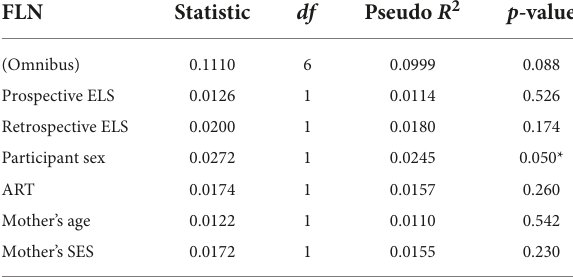
TABLE 4 Multivariate distance matrix regression (MDMR) analysis results for the fronto-limbic network (FLN), with prospective ELS and retrospective ELS as independent variables, and participant sex, ART, mother’s age and mother’s SES as